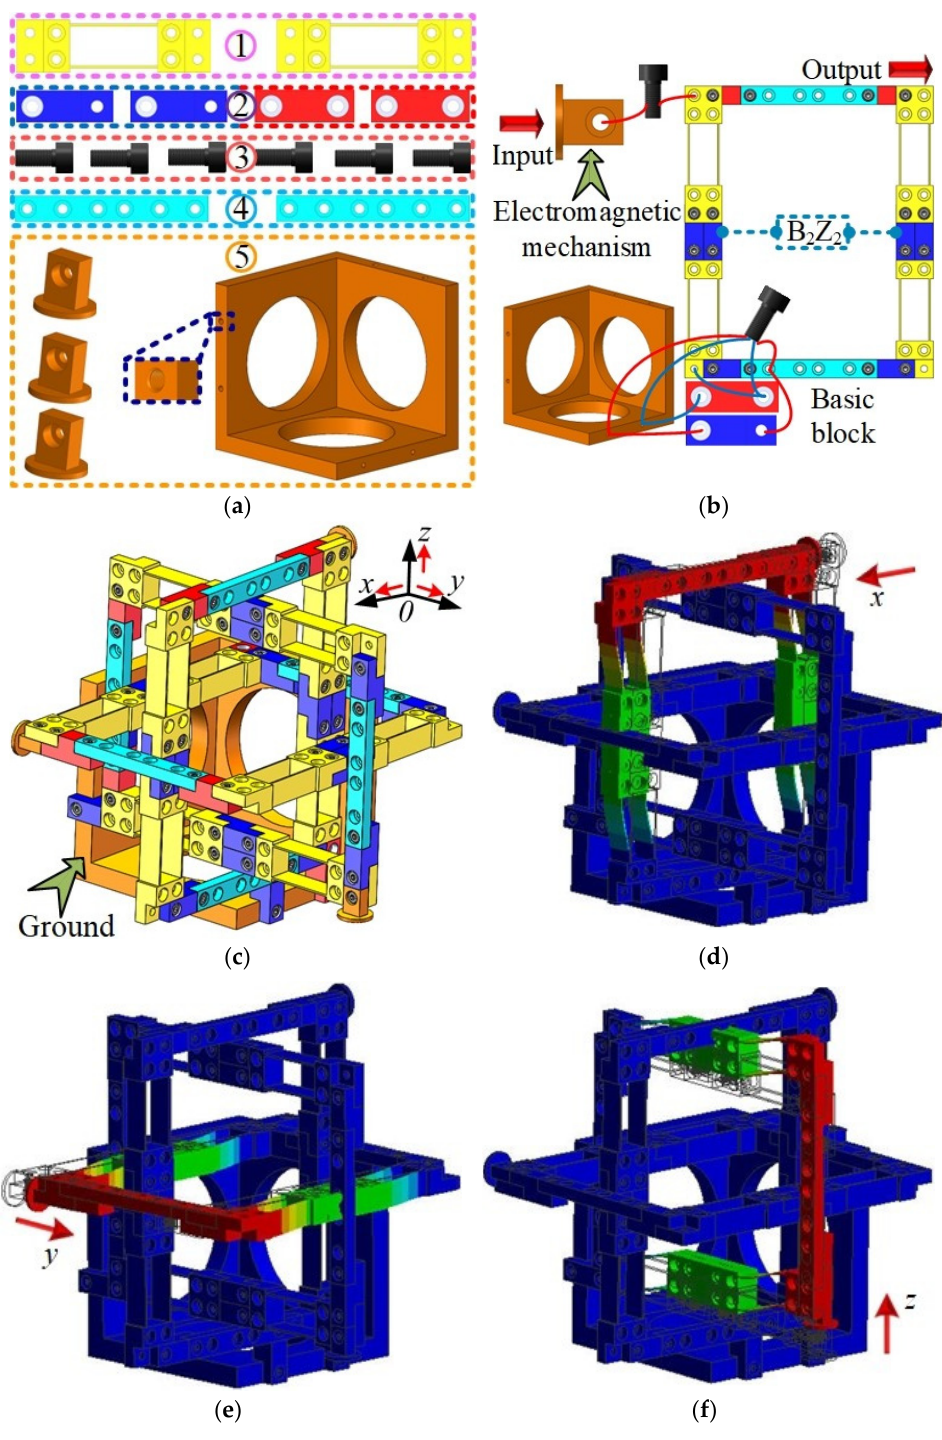
Figure 10. Flexure-based parallel XYZ MPS: ( a ) module library; ( b ) assembly of modules; ( c ) display of flexure-based XYZ MPS; ( d – f ) Simulation of XYZ MPS along X , Y , and Z axes, respectively. 1, transmission modules; 2, Z-type and T-type connection modules; 3, bolts; 4, I-type connection modules; 5, ground and electromagnetism custom modules.